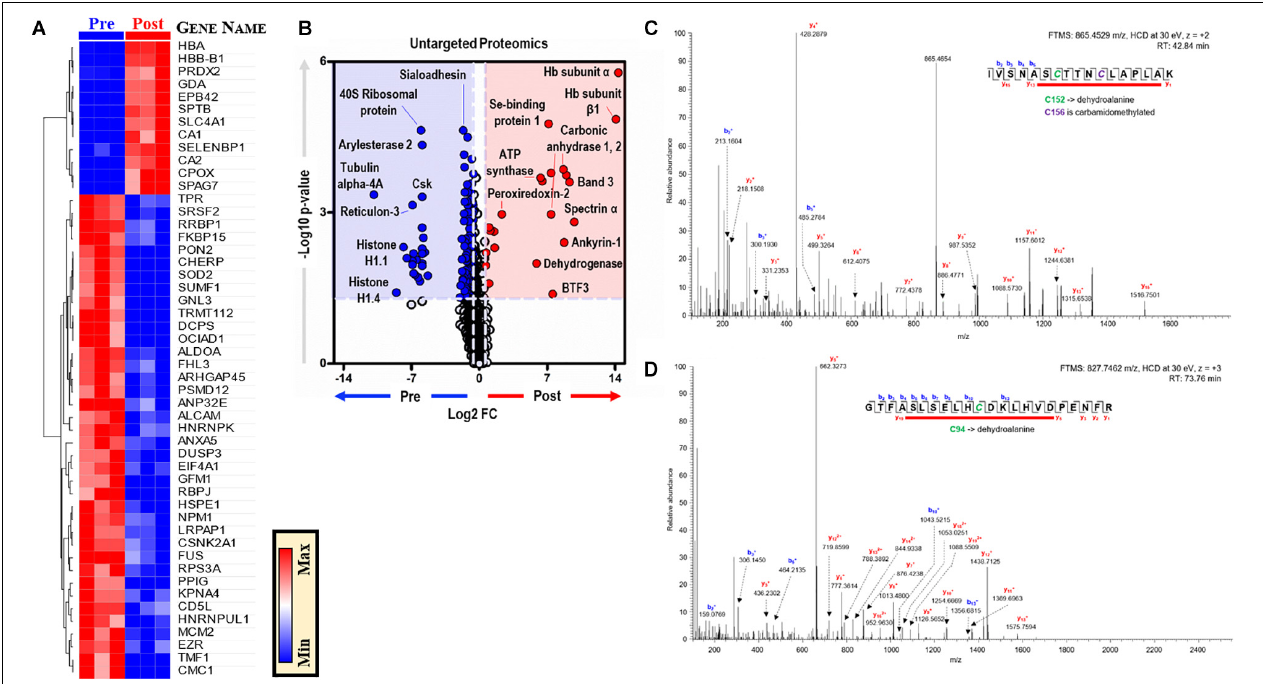
FIGURE 6 | EP alters the BMDM proteome. (A) . The top 50 proteins in BMDMs that are significantly changed by EP (A) . Values are plotted as a hierarchically-clustered heat map based on p -value with proteins listed by gene name. Univariate analysis of the BMDM proteome using untargeted proteomics to identify proteins that change due to EP (B) . The region highlighted in red (FC > 1.5; p < 0.05) indicates proteins present in significantly higher amounts in BMDMs after EP (Post); whereas, the region highlighted in blue (FC < 0.67; p < 0.05) indicates proteins found to be accumulated in BMDMs before EP (Pre). Representative tandem mass spectrometry spectra with deduced protein sequences for glyceraldehyde 3-phosphate dehydrogenase (GAPDH) (C) and hemoglobin- β (D) . Dehydroalanine modification of Cys152 and carbamidomethylation of Cys156 in the active site of GAPDH (C) . Dehydroalanine modification of Cys94 adjacent to the heme binding site (H93, proximal ) in the hemoglobin- β chain (D)